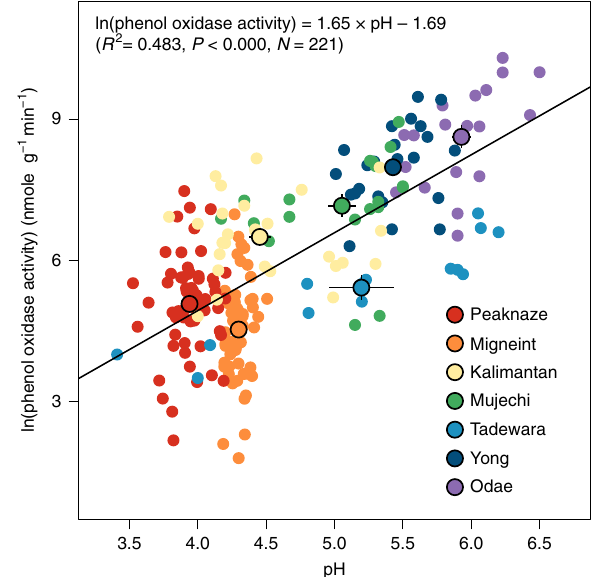
Fig. 1 A positive correlation between pH and logarithm of phenol oxidase activities in seven peatlands. Small points are individual measurements and large points are mean values of each peatland. Error bars indicate the standard error of